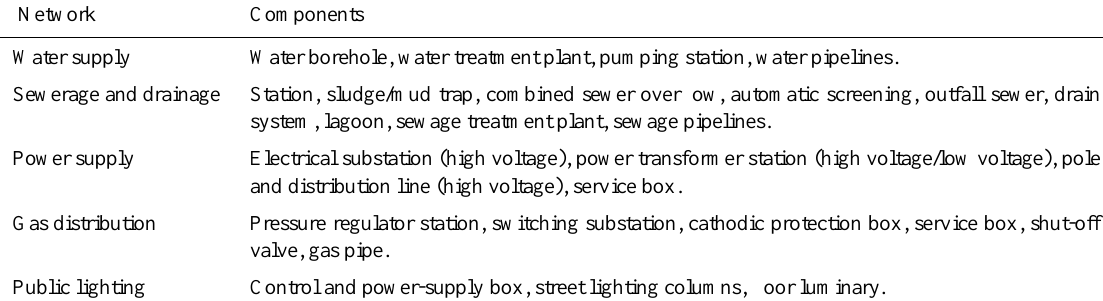
Table 2. The network components analysed for the construction of damage-dysfunction matrices.